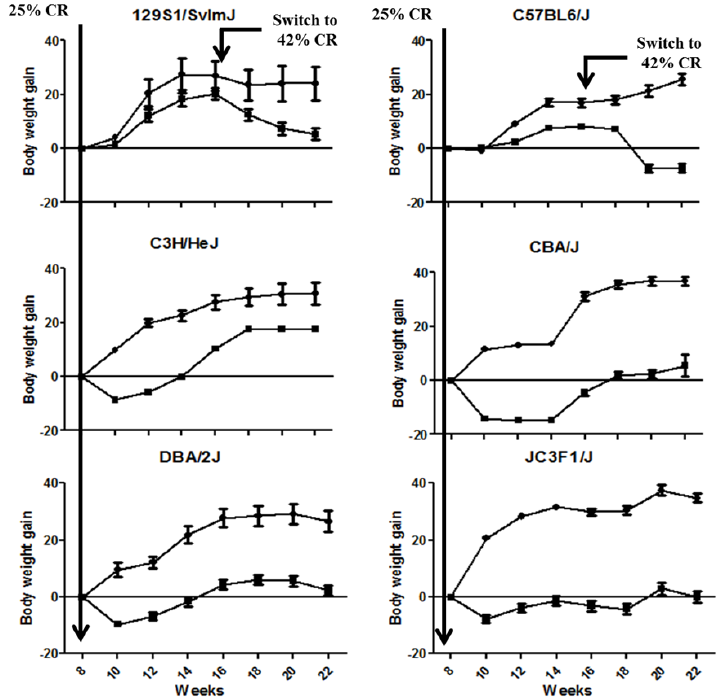
Figure 1. Body weight gain overtime for the different strains of mice under control diet or calorie restriction (CR). Data are reported as mean ± SE values for the body weight gain calculated from Week 8 onwards. Control and CR groups are plotted with dot and square shapes, respectively.